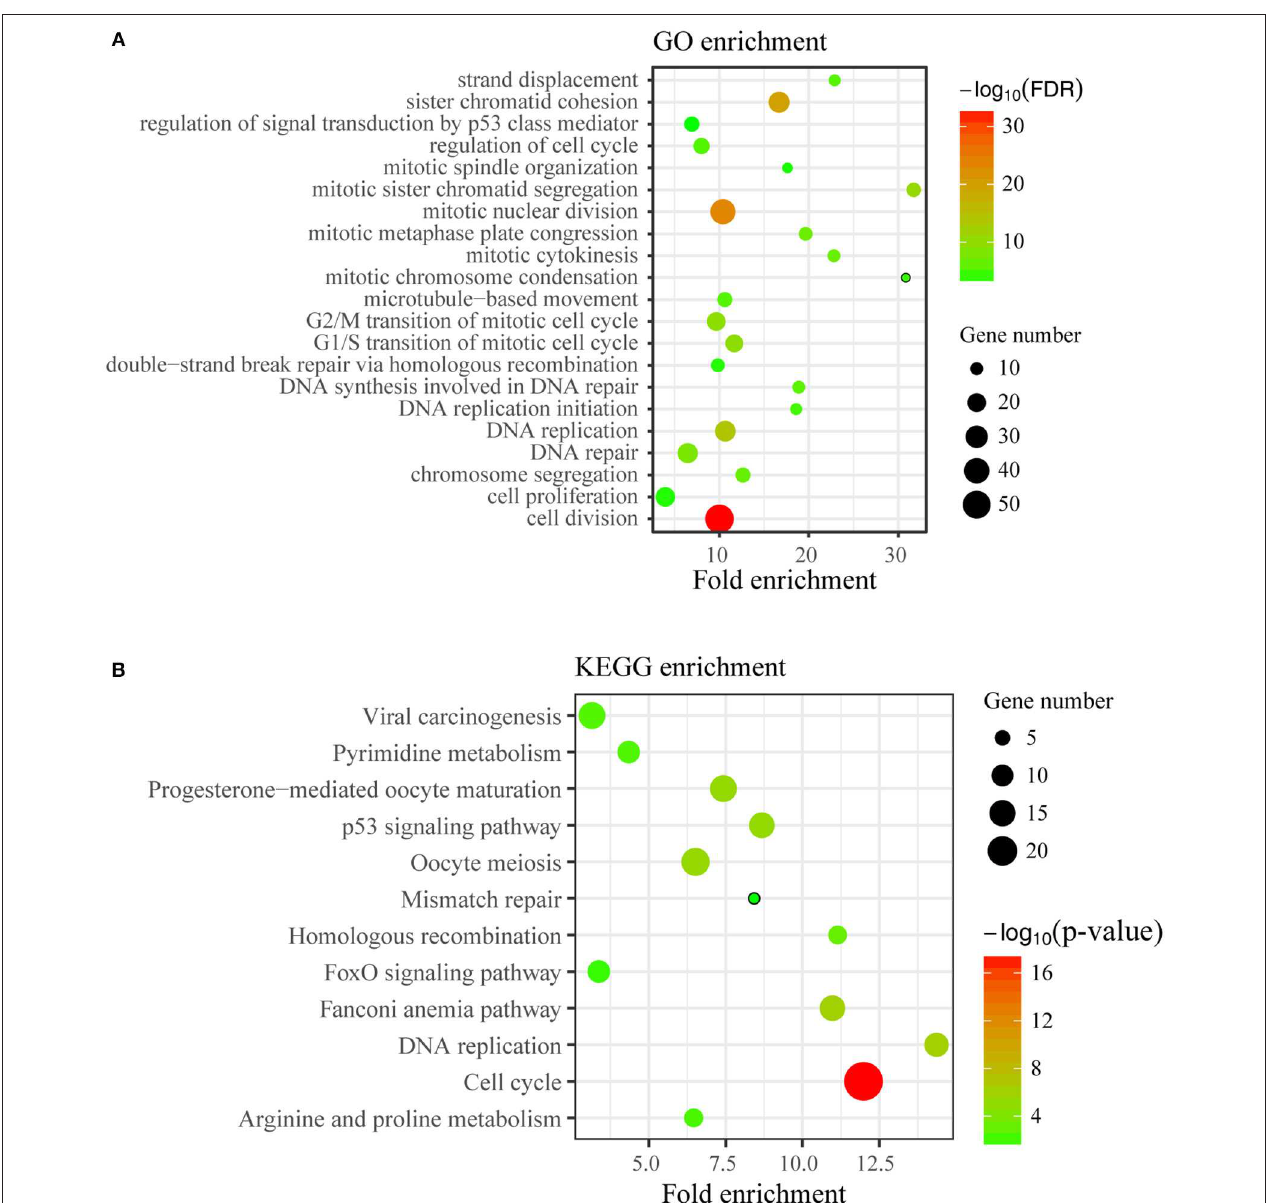
FIGURE 7 | Enrichment analysis of DEGs. (A) Top21 of Gene Ontology (GO) enrichment (FDR < 0.05) of differentially expressed genes were displayed. The y-axis represents the Gene Ontology term name and the x-axis represents fold enrichment of matched ontology categories. The circle size represents the gene count of matched term and the circle color showed the FDR. (B) KEGG pathway analysis on differentially expressed genes was conducted. The y-axis represents the pathway term name and the x-axis represents fold enrichment. The circle size represents the gene count of matched term and the circle color represents the p